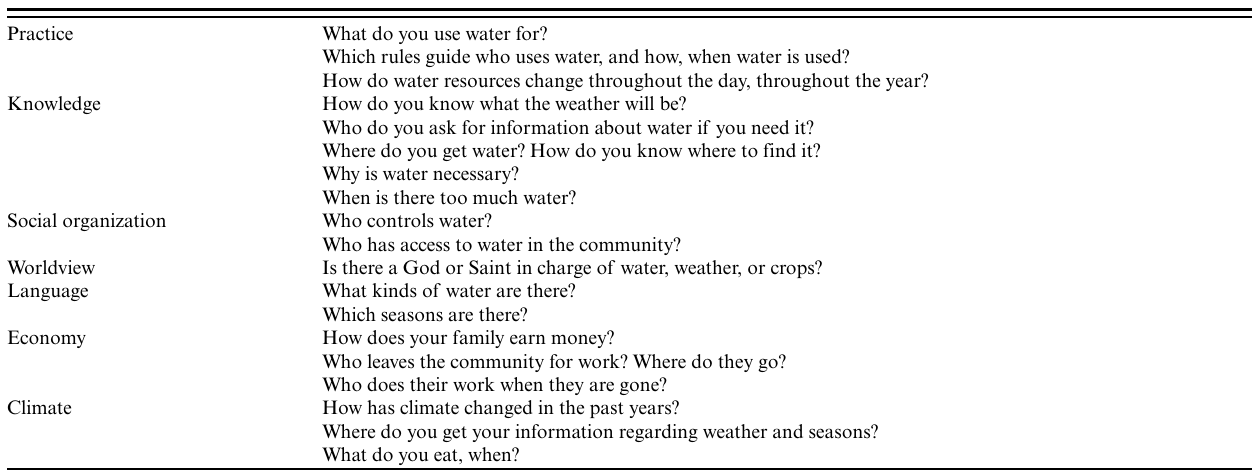
Table 1 . Interview guide categories and sample